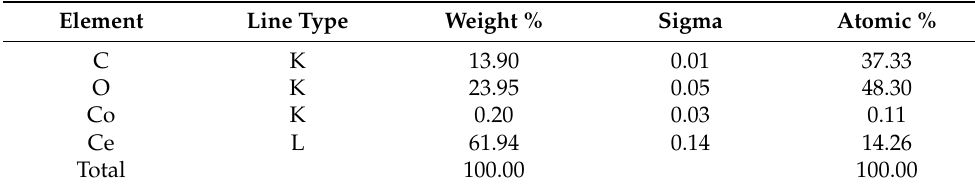
Figure 4. EDX spectrum of the prepared Co/CeO 2 /C nanocomposite. Table 1. EDX analysis of the Co/CeO 2 /C nanocomposite.